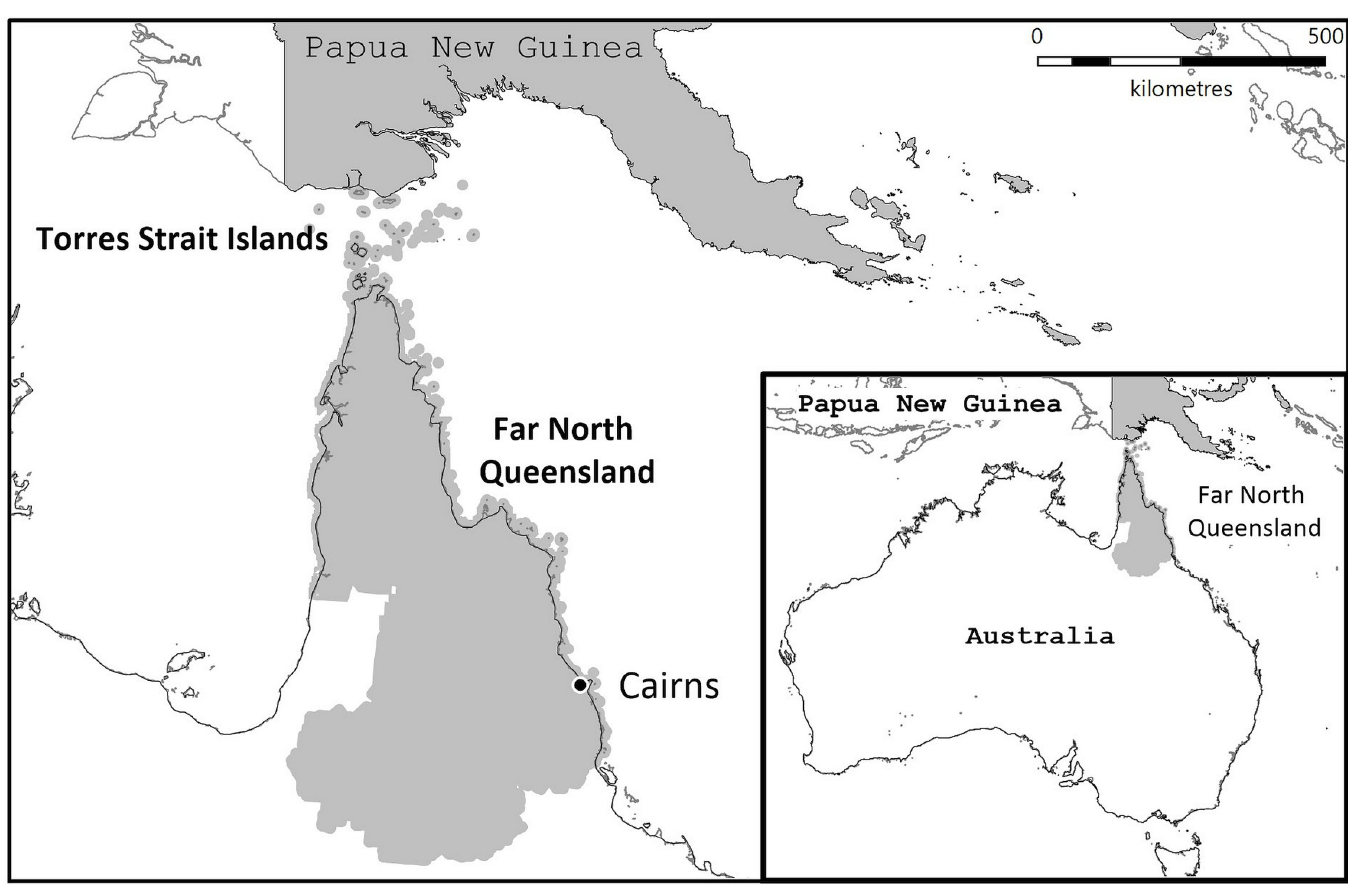
Fig 1. Map Far North Queensland, Australia, highlighting its proximity to Papua New Guinea. The map was constructed using mapping software (MapInfo version 15.02, Connecticut, USA) using data provided by the State of Queensland (QSpatial). Queensland Place Names—State of Queensland (Department of Natural Resources, Mines and Energy) 2019, available under Creative Commons Attribution 4.0 International licence https://creativecommons.org/licenses/by/4.0/. ‘Coastline and state border–Queensland—State of Queensland (Department of Natural Resources, Mines and Energy) 2019, available under Creative Commons Attribution 4.0